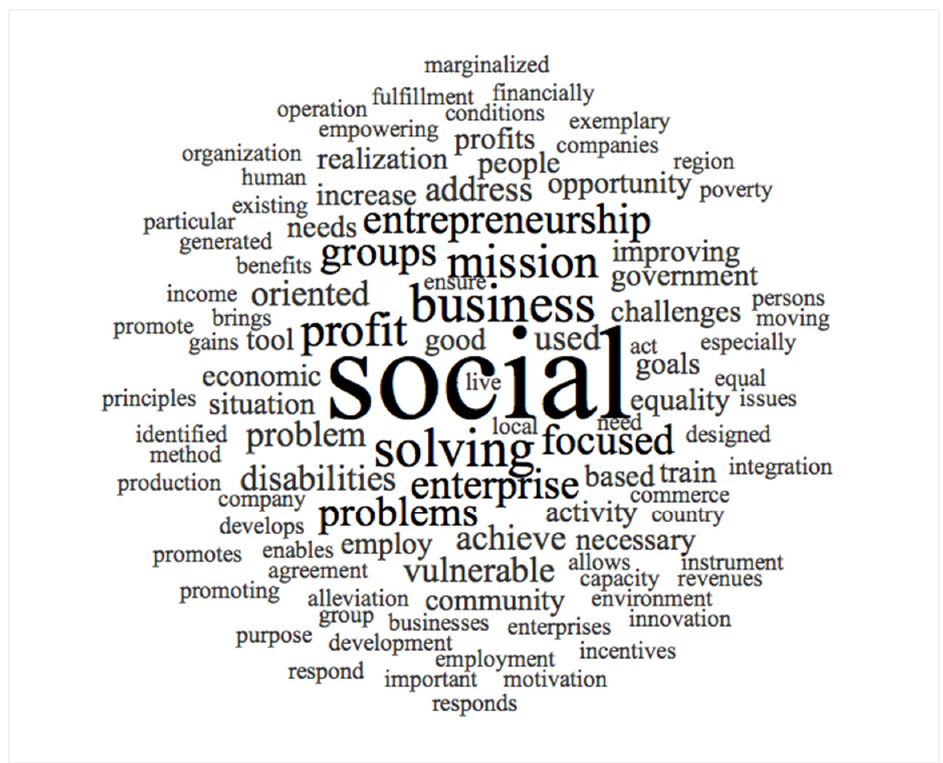
Figure 7. Word frequency. Source: Authors’ elaboration using NVivo